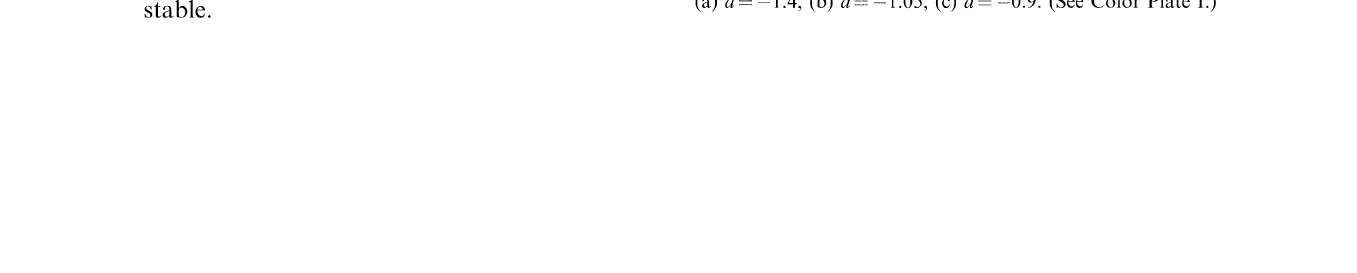
FIGURE 2 Period-6 attractor (crosses), its basin of attrac- tion (red) and chaotic saddle (yellow) of system (1), /9=